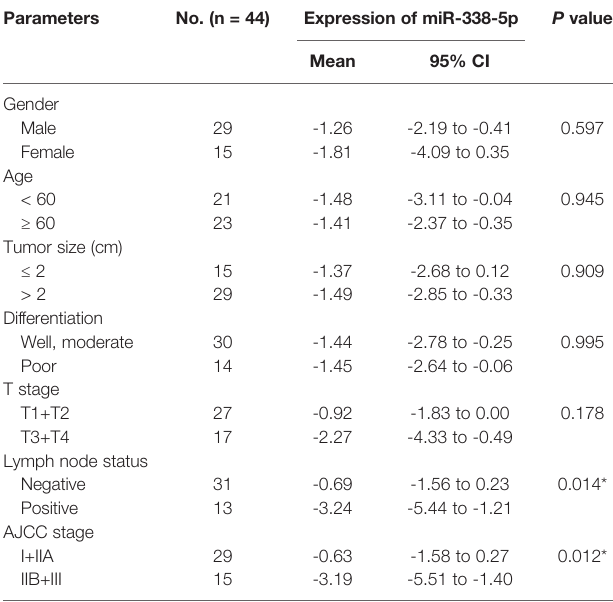
TABLE 1 | Correlations between miR-338-5p and clinicopathologic parameters in PC patients.